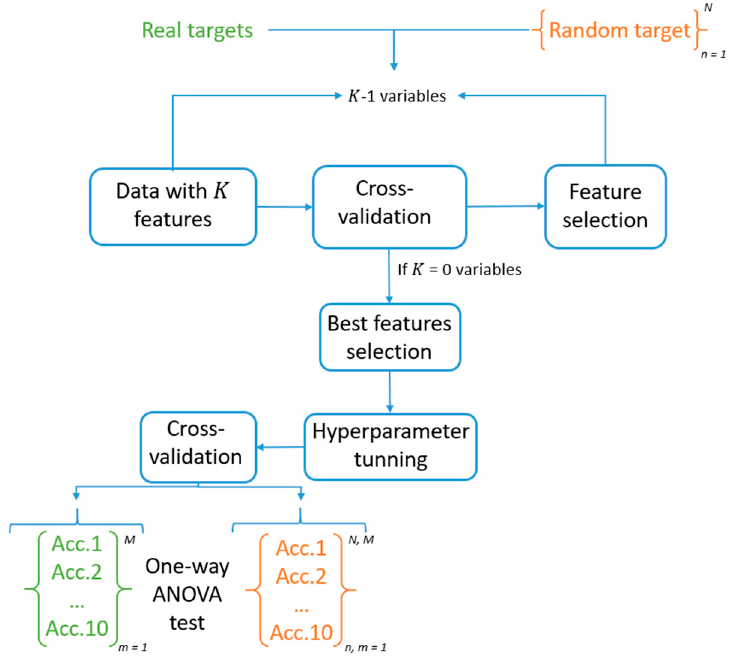
Figure 2. Scheme of ML pipeline and its overfitting check using a set of generated random targets. M indicates the number of the CV repetitions set to 4, and N the number of random targets generated, equal to 6.